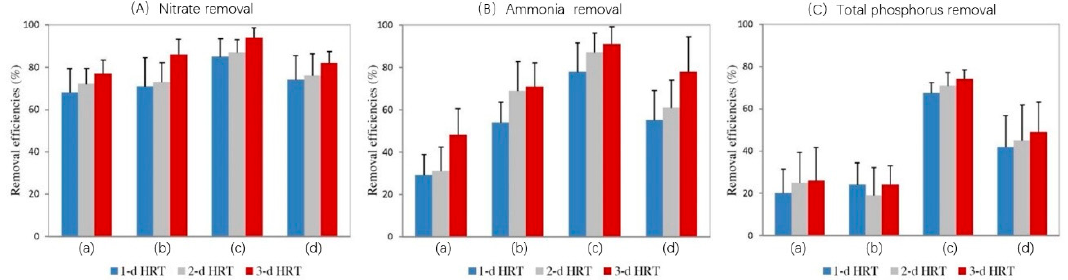
Figure 2. Nutrient removal efficiencies (%) at different HRTs (day). Vertical error bars present standard deviation. ( A ) nitrate removal; ( B ) ammonia removal; and ( C ) total phosphorus removal.